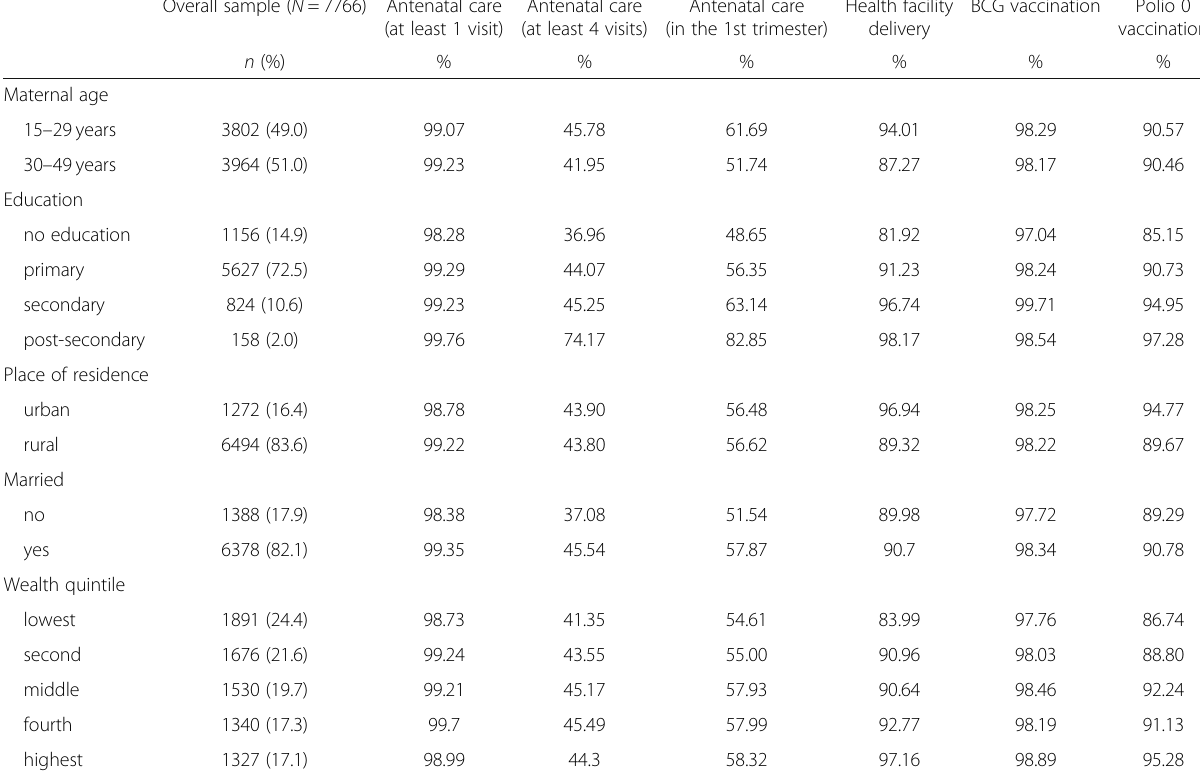
Table 1 Sociodemographic characteristics and health services use among respondents to the Rwanda Demographic and Health Survey, November 2014 – April 2015